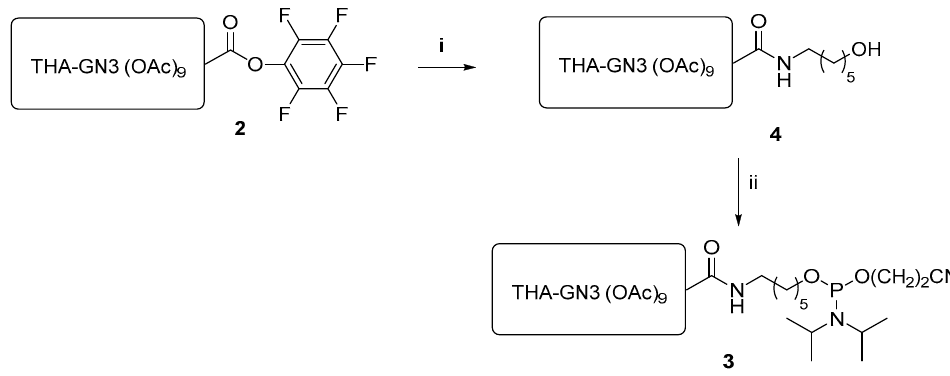
Scheme 1. Synthetic protocol for THA-GalNAc phosphoramidite 3 . Reagents and conditions: ( i ) 6- amino-1-hexanol, NEt 3 , THF, 73%; and ( ii ) P(N i Pr 2 ) 2 -O(CH 2 ) 2 CN, ETT, CH 2 Cl 2 , 75%.